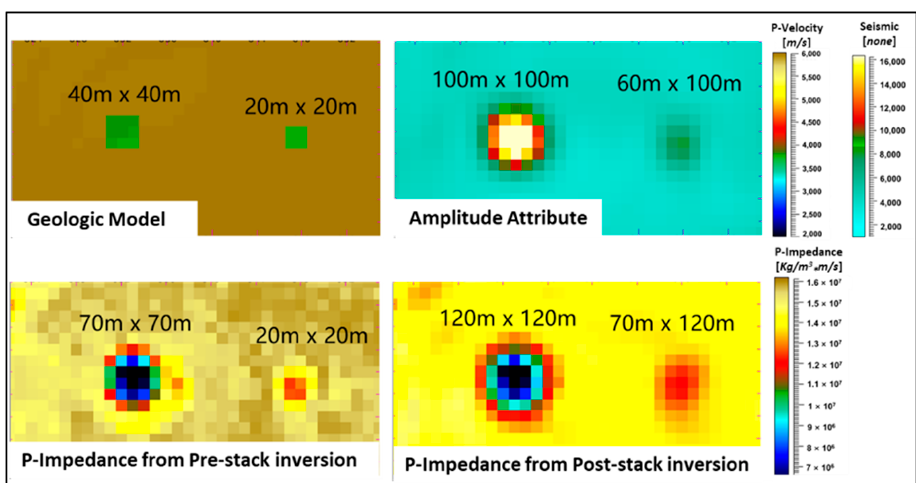
Figure 8. Comparisons of prediction caves size (map): post-stack inversion prediction; pre-stack inversion prediction; seismic attribute prediction. The sizes of the caves predicted by pre-stack inversion are closest to those of the geological model.